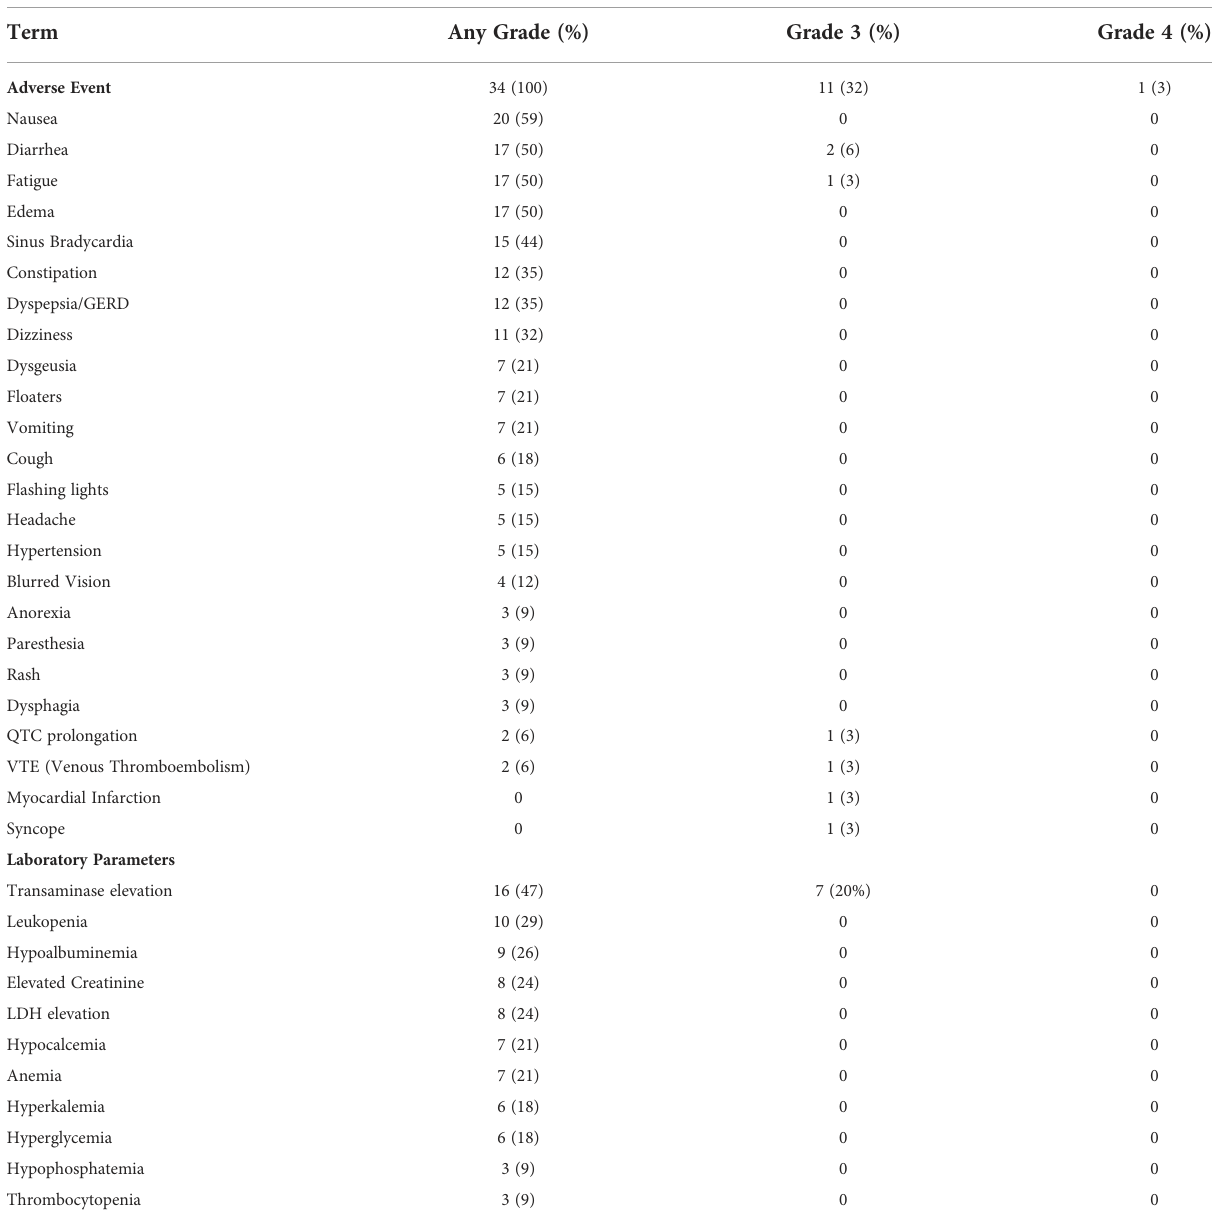
TABLE 4 All Cause Adverse Events